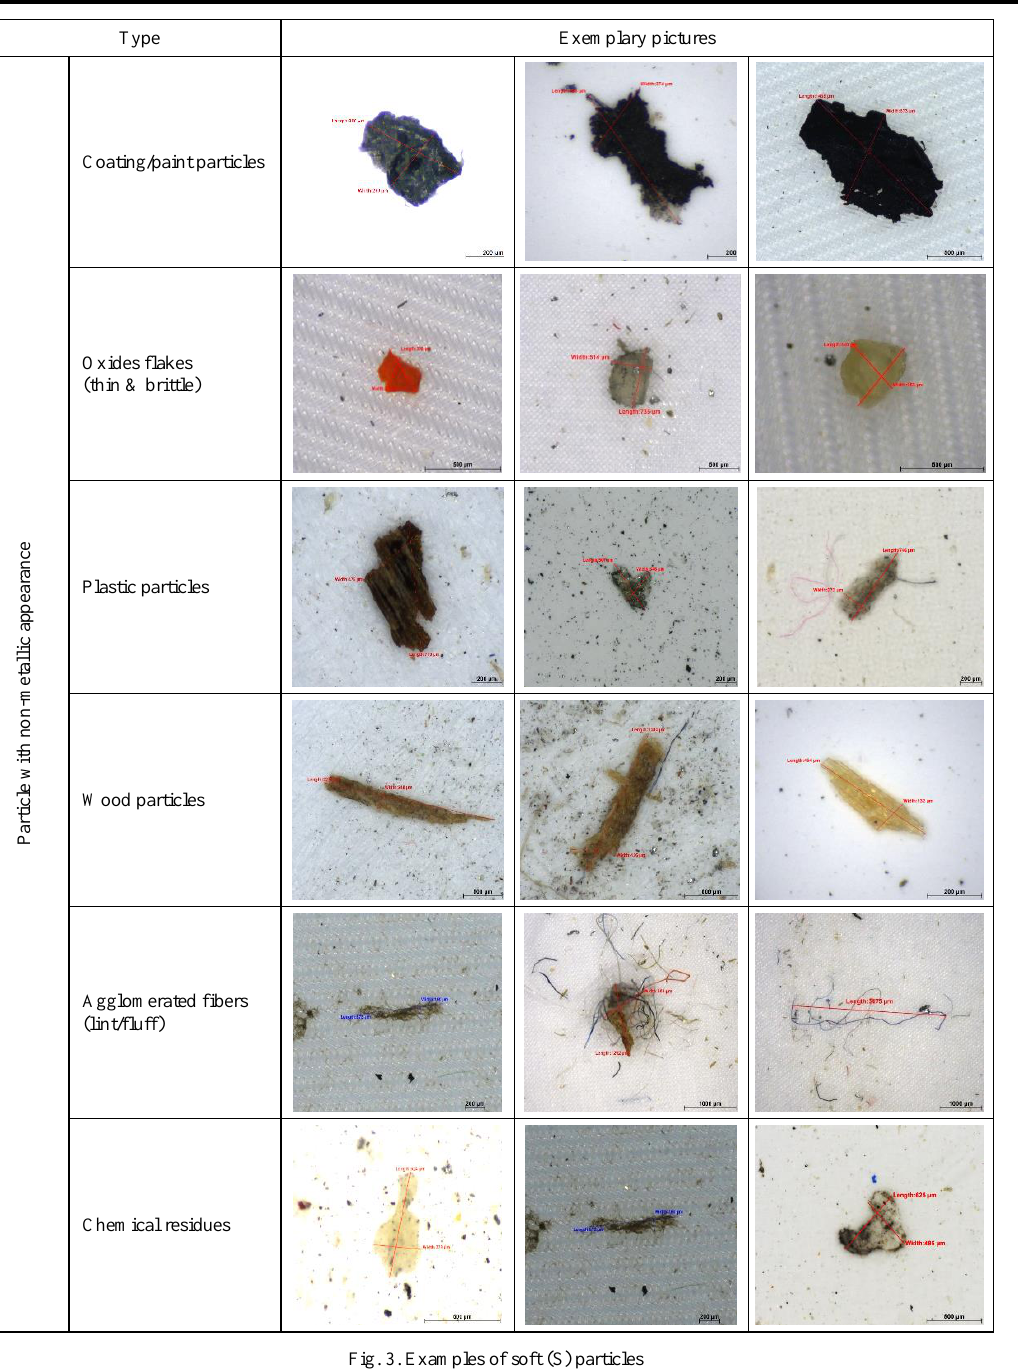
Fig. 3. Examples of soft (S) particles